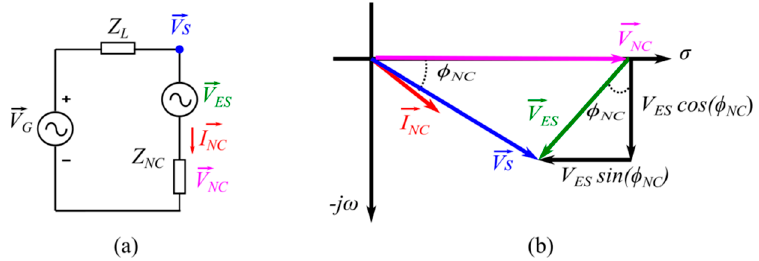
Figure 2. Electric spring steady-state model: ( a ) simplified electrical circuit and ( b ) phasor